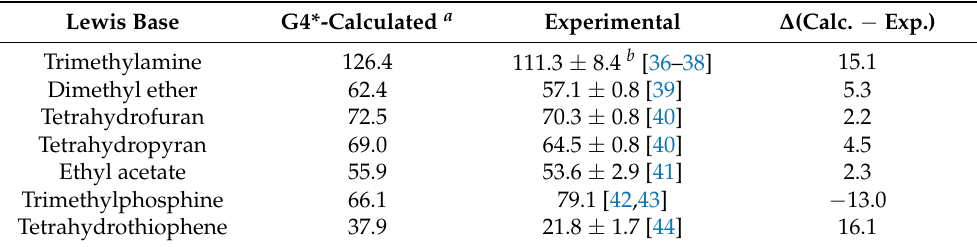
Table 1. Gas-phase enthalpies ( − ∆ H ) of adduct formation with Lewis bases; values in kJ · mol − 1 at 298 K unless otherwise